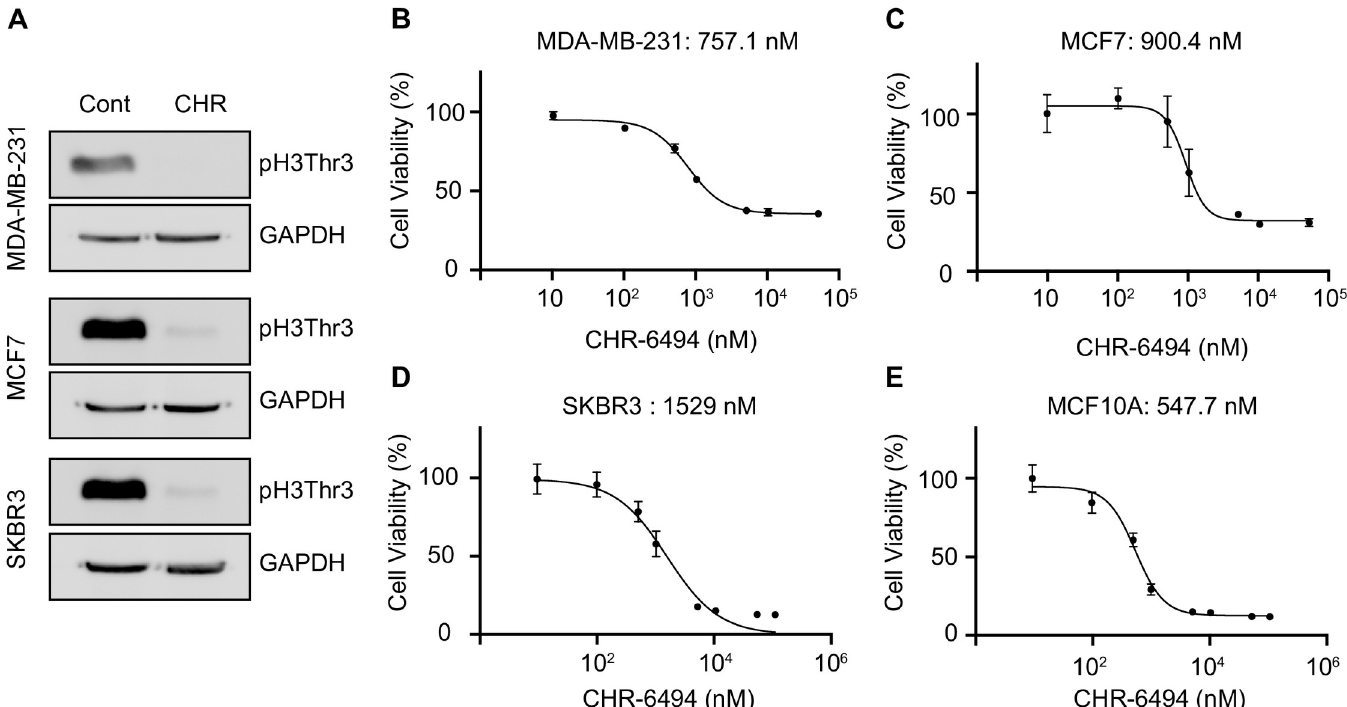
Fig 2. CHR-6494 inhibits the proliferation of breast cancer cells in vitro . (A) Immunoblotting analysis of pH3T3. The breast cancer cells were treated with DMSO or CHR-6494 (1000 nM) for 24 h. The effects of CHR-6494 on the viability of MDA-MB-231 (B), MCF7 (C), SKBR3 (D), and MCF10A (E) cells were determined by XTT assay. IC 50 values are shown for each cell line. Data are presented as the mean ± SD of three independent experiments.